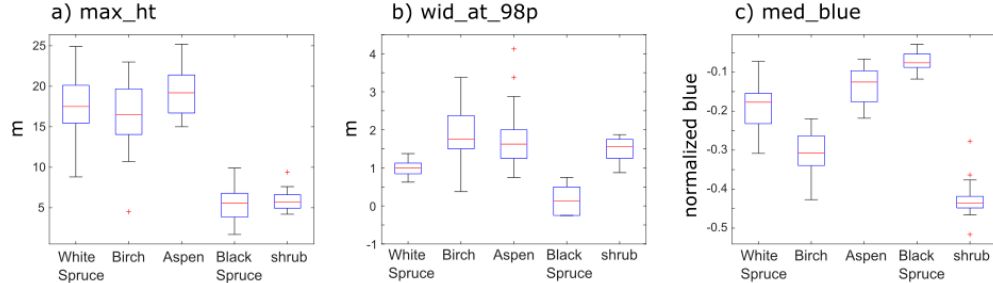
Figure 4. Species separability boxplots for the three variables maximizing species separability: ( a ) max crown height; ( b ) crown width at 98th percentile height; ( c ) median blueness.